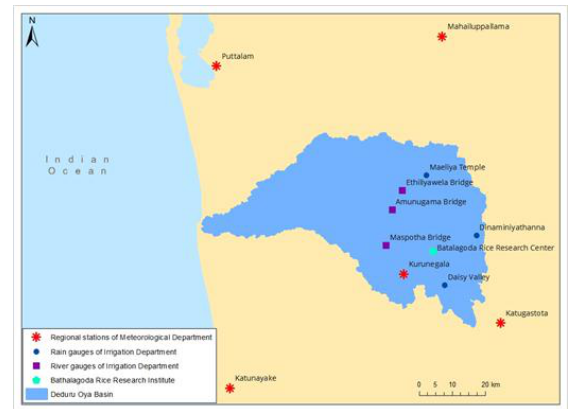
Figure 3. The existing hydrometeorological network of